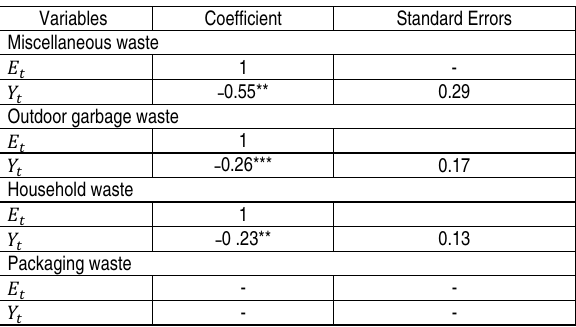
Table 5. Cointegrating